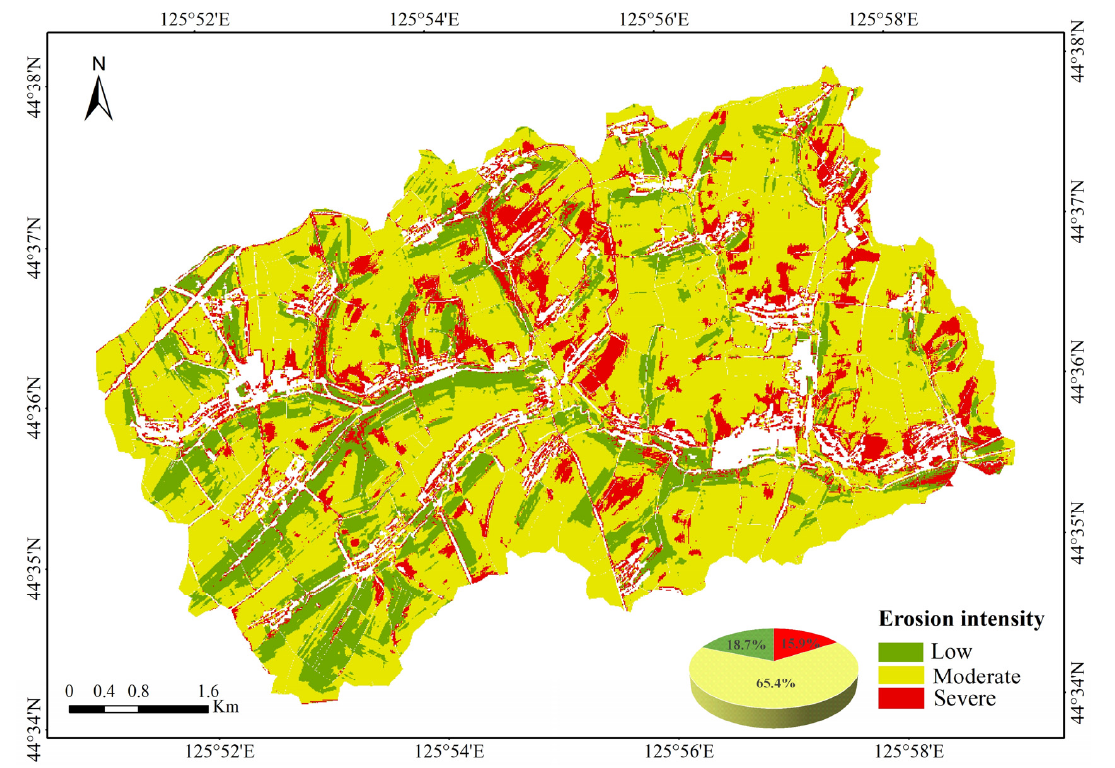
Figure 9. Soil erosion intensity map at 10 m resolution. The classification criteria were based on the results from Figure 8.